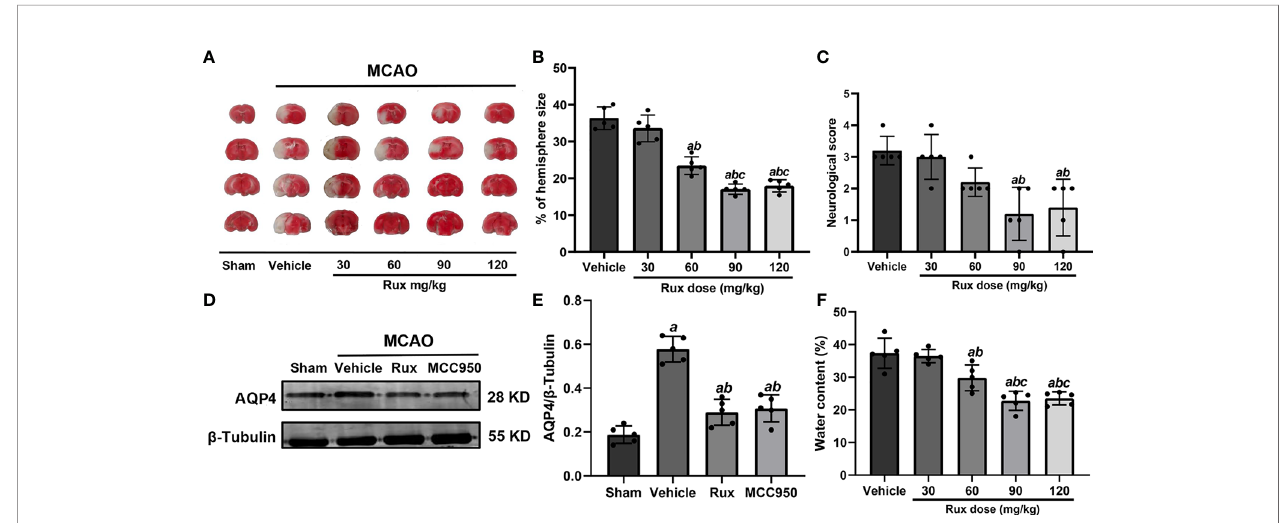
FIGURE 1 | Rux reduced infarct size, neurological de fi cits and cerebral edema in mice after MCAO. (A) Representative TTC-stained slices showing infarction in vehicle- and Rux-treated mice. (B) Quantitative analysis of the infarct size is presented as a percentage of the contralateral hemisphere size 3 days after stroke. (C) Neurological scores were determined 3 days after MCAO. (D) Representative western blots showing that Rux application reduced AQP4 expression. (E) Quanti fi cation of AQP4 expression. (F) Quanti fi cation of water content. Means ± SD. n = 5 in each group. a P < 0.05 versus the vehicle group; b P < 0.05 versus the 30 mg/kg Rux group; c P < 0.05 versus the 60 mg/kg Rux